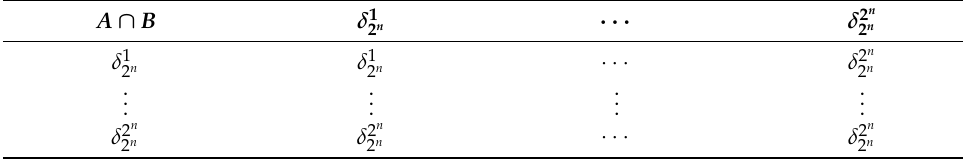
Table 9. Intersection in vector